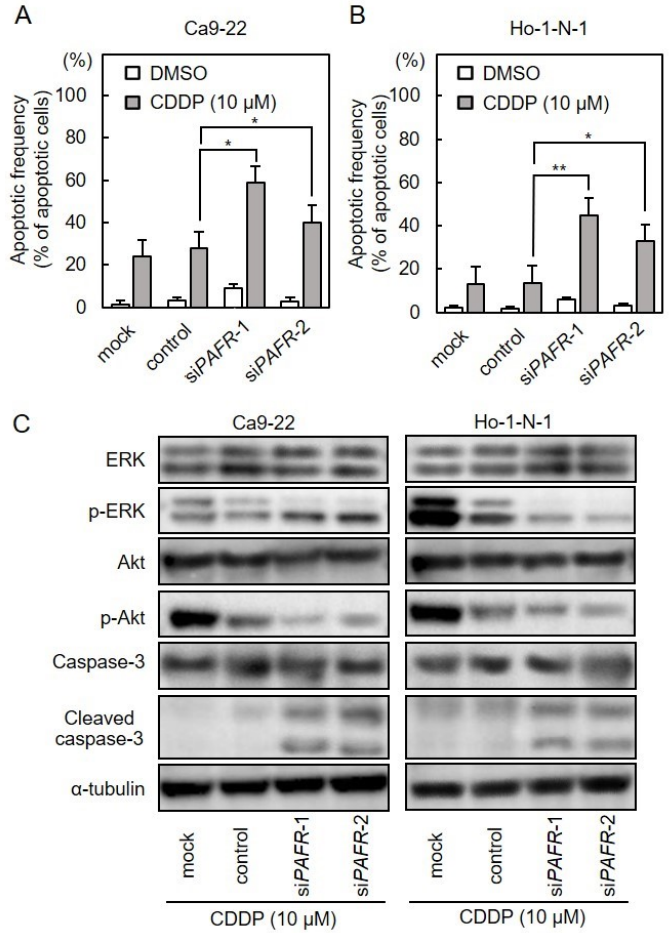
Figure 5. Effects of PAFR knockdown on apoptosis and its downstream pathways. ( A , B ) Flow cytometric assays were used to assess apoptosis frequency in si PAFR -transfected cells after CDDP treatment. Each value represents mean values obtained from three separate experiments. Asterisks indicate statistical significance (Ca9-22 ( A ) and Ho-1-N-1 ( B ); Unpaired t -test; *, p < 0.05; **, p < 0.01). ( C ) Immunoblot analysis of the phosphorylation of ERK, phosphorylation of Akt and cleaved caspase-3. Decreased ERK and Akt phosphorylation was observed in si PAFR -transfected cells in both Ho-1-N-1 and Ca9-22 after treatment with CDDP. In addition, highly cleaved caspase-3, an apoptosis marker, was observed in both Ca9-22 and Ho-1-N-1 after treatment with CDDP. α -tubulin protein levels were used as loading control. Detailed information about the Western blotting can be found at Figure S3 and Table S3. CDDP, cisplatin.